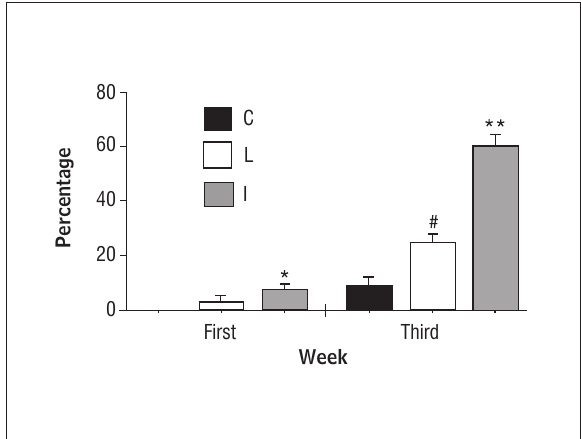
Figure 3 - Volume densities of newly formed bone in the callus tissue of C, L, and I groups of rats at the end of the 1 st and 3 rd